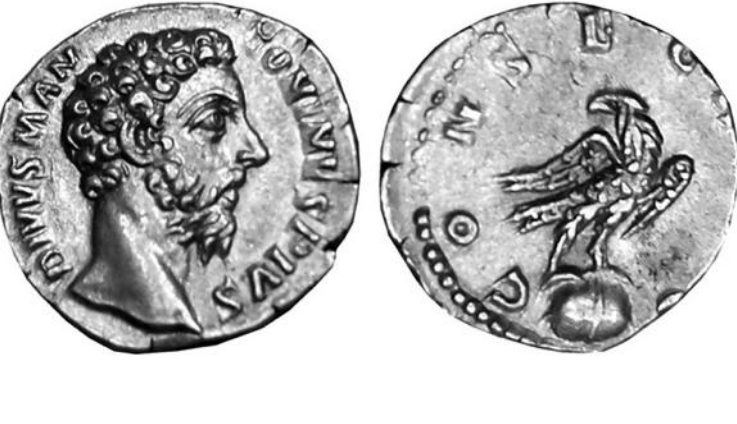
Figure 3. A consecratio denarius declares Marcus Aurelius a divine being ( divus ), while Jupiter‘s eagle sits atop the celestial orb with intersecting lines: Plato‘s X, the visible reflection of the Cosmic Soul in the heavens ( RIC III [9] (Commodus)